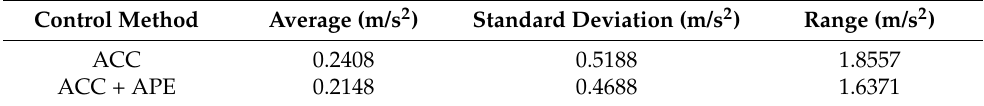
Figure 4. Comparison results for ACC and ACC − APE: ( a ) acceleration; ( b ) speed; ( c ) throttle. Table 1. Statistics of the acceleration results of the host vehicle.